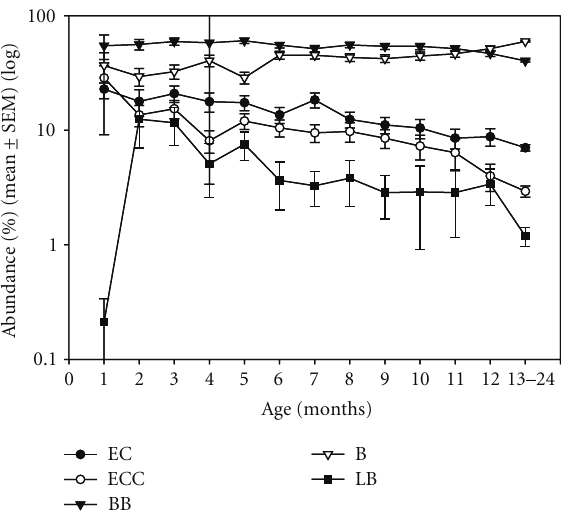
Figure 5: Abundance (%) (mean ± SEM) by age (years) of E. coli , Enterococcus sp ., as well as L actobacillus sp ., Bifidobacteria , and Bacteroides sp